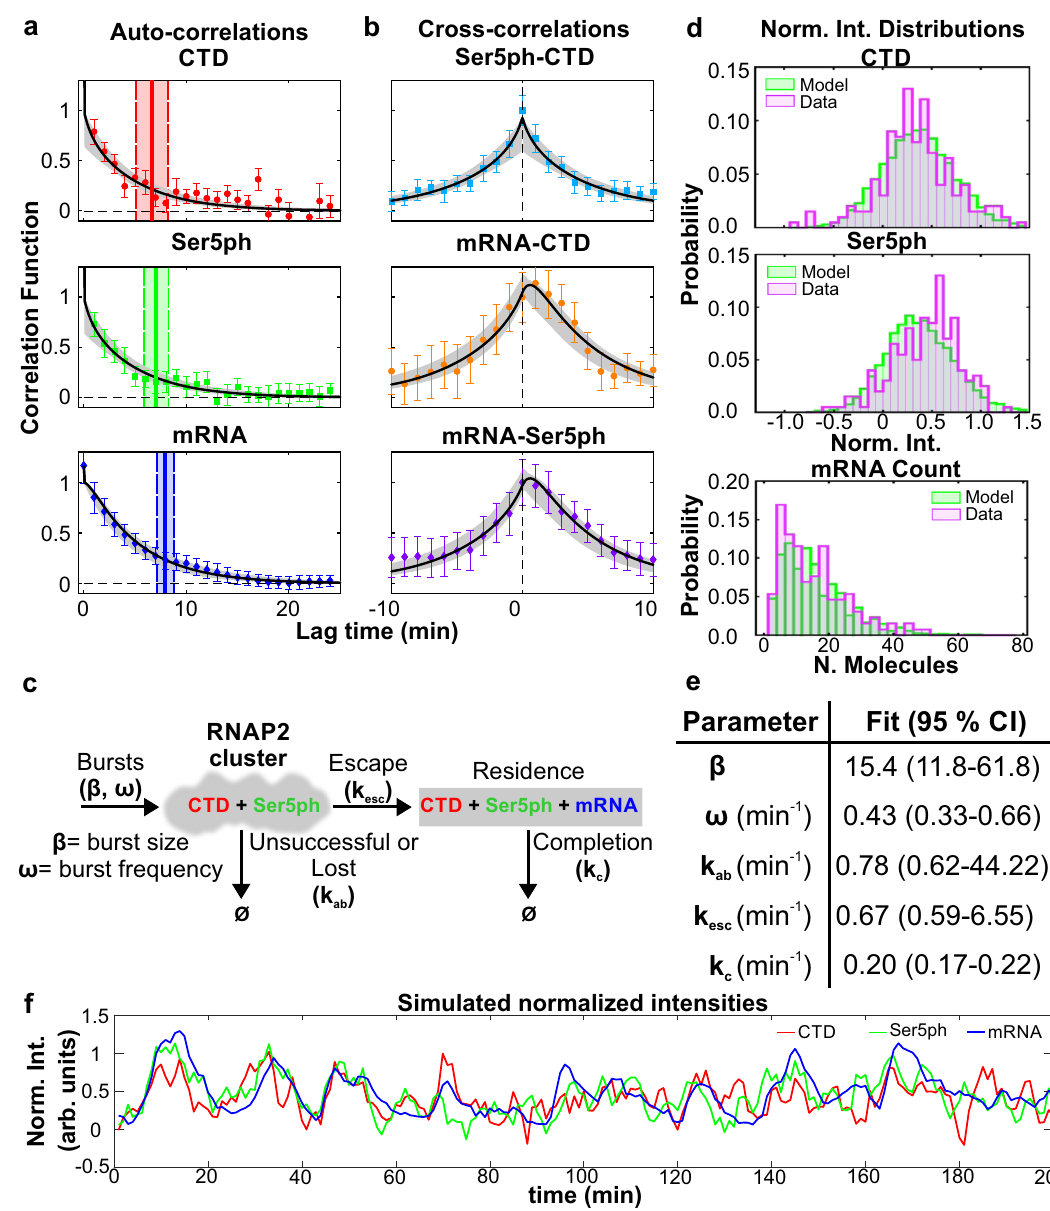
Fig. 3 Fluorescence auto- and cross-correlations at the HIV-1 reporter gene are well fi t by a unifying model of transcription. a , b Measured and modeled ( a ) auto-correlation functions AC ð τ Þ = G ð 0 Þ for each signal: CTD-RNAP2 (red circles), Ser5ph-RNAP2 (green squares), and mRNA (blue diamonds). Dwell time is de fi ned as the time at which the autocovariance dropped below 20% of its zero-lag value (vertical full lines). Dwell time uncertainty is estimated from the model using the standard deviation from 400 simulated data sets, each with 20 cells over 200 min with 1 min simulation resolution (vertical dashed lines). b Cross-correlation function CC ð τ Þ = G ð 0 Þ between signal pairs: Ser5ph-RNAP2 and CTD-RNAP2 (cyan squares), mRNA and CTD-RNAP2 (orange circles), and mRNA and Ser5ph-RNAP2 (purple diamonds) at the transcription site. Model Maximum Likelihood Estimate (MLE) fi t in black and sampled uncertainty in gray. c A simple model to capture RNAP2 fl uctuation dynamics at the HIV-1 reporter gene. RNAP2 enters the transcription cluster with an average geometric burst with average burst size, β , and burst frequency, ω . Phosphorylation of Serine 5 is assumed to be fast (<<1 min) and/or the RNAP2 enters in a pre-phosphorylated form. RNAP2 can be lost from the cluster with rate k ab or escape with rate k esc . RNAP2 completes transcription with rate k c . d Probability distributions for CTD-RNAP2 and Ser5ph-RNAP2 (arbitrary units of fl uorescence), and mRNA (units of mature mRNA) for experimental data (purple) and model MLE predictions (green). e MLE parameters and 95% con fi dence interval (CI) range. Statistics presented for the data are the sample means ± S.E.M. n = number of cells/number of independent experiments (20/8). f Simulated trajectory (with shot noise equal to that of experiments) of CTD-RNAP2 (red), Ser5ph-RNAP2 (green), and mRNA (blue) intensities normalized to have a 95 percentile of exploration of how each model parameter affects model predictions, including trajectories, auto- and cross-correlations, distributions of spot intensities, simulated ChIP data, and several derived quantities to describe the CTD-RNAP2, Ser5ph-RNAP2, and mRNA burst dynamics (Supplementary Fig. 9).